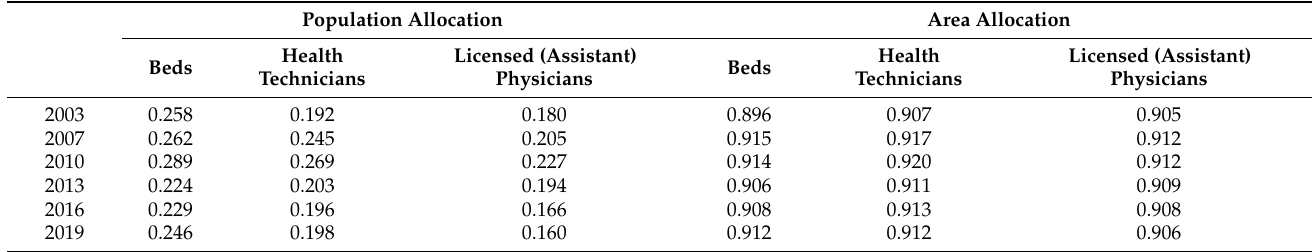
Table 2. Gini coefficient of medical and health resources in Taiyuan, 2003–2019.